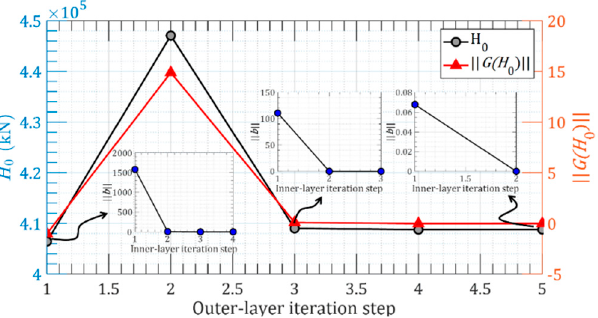
Figure 6. Outer-layer and inner-layer iteration results for 2D parallel main cables.